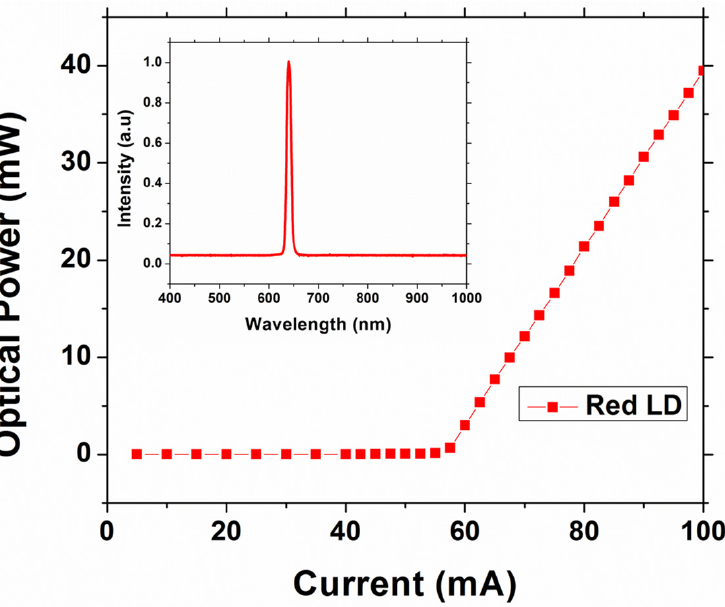
Figure 3. Measured characteristics of the red LD used in the experiment. Inset: measured optical spectrum.